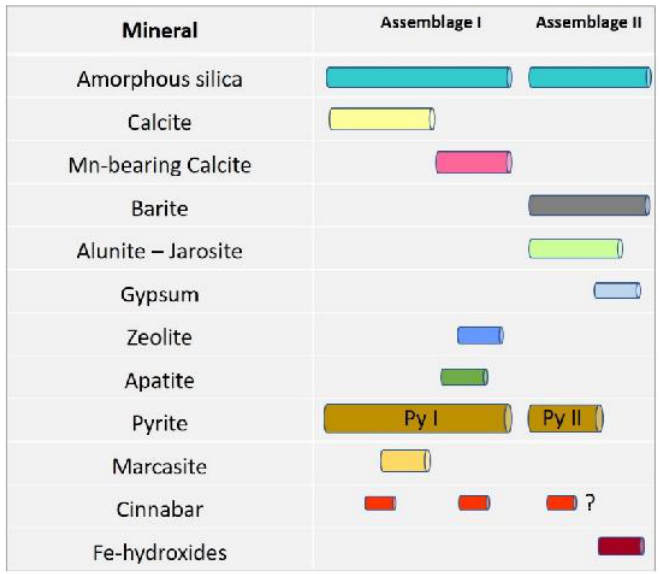
Figure 8. Paragenetic sequence of hydrothermal mineralization at Paleochori Bay. Thickness of the bars indicate relative minerals abundances.